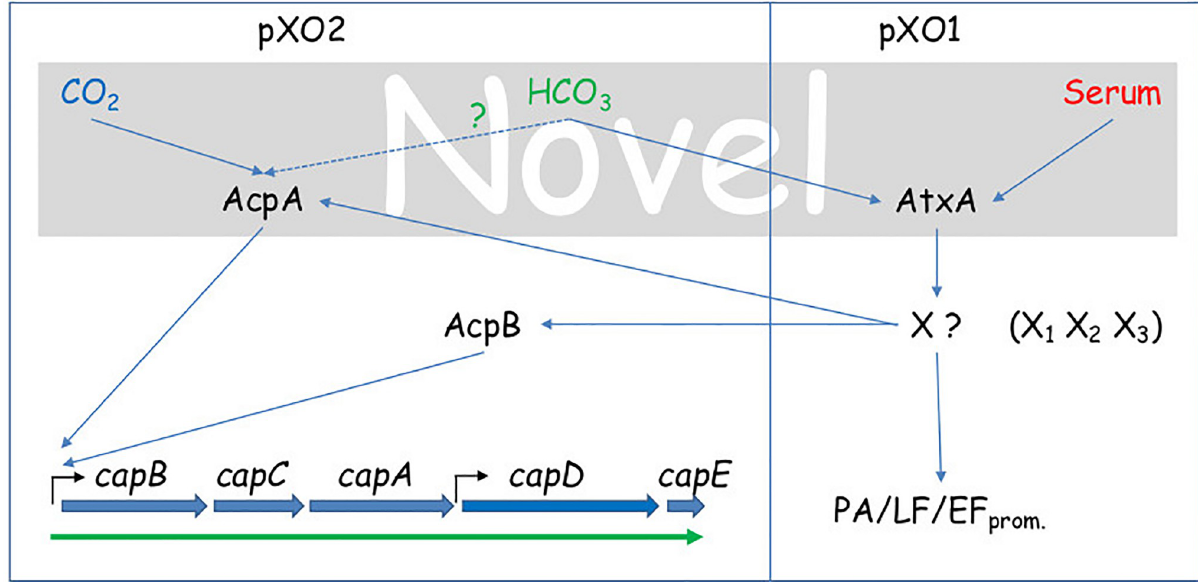
Fig 7. Proposed regulatory scheme for CO 2 , Serum and HCO3- regulation of capsule production and toxin secretion. The three environmental signals that were studied are color coded; CO 2 in blue, HCO 3- in green and serum in red. The gray background indicates the novel part of the regulation pathway proposed based on this